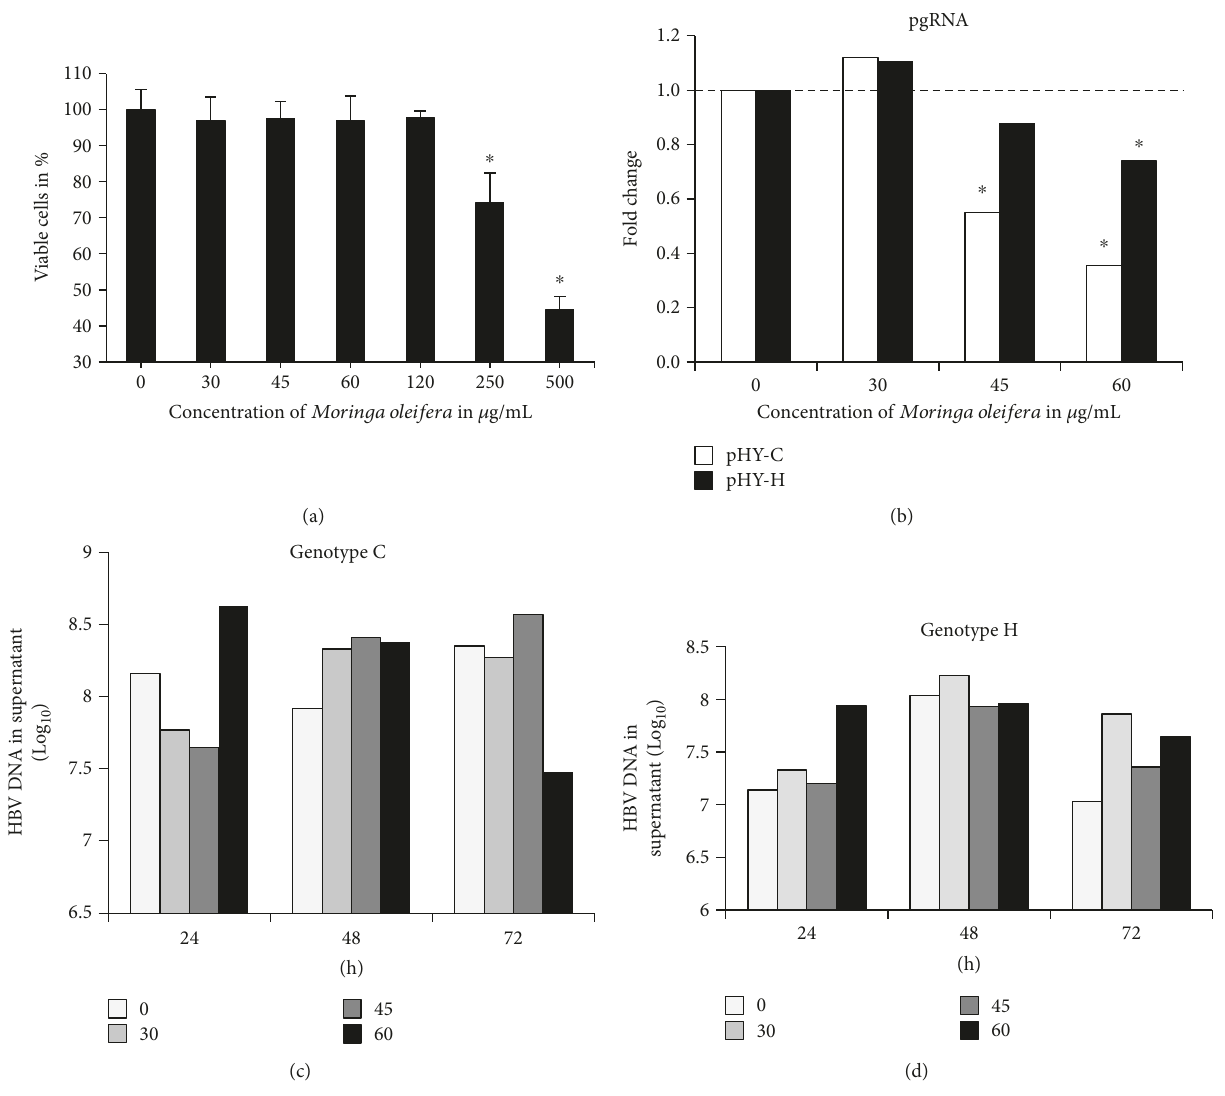
Figure 1: (a) E ff ect of aqueous leaf extract of Moringa oleifera on the viability of Huh7 cells. ∗ p < 0 05 . (b) pgRNA expression of Huh7 cells transfected with genotype C (white bars) or H (black bars) of HBV and treated with Moringa oleifera . Fold change (2 − ΔΔ Ct ) was calculated with reference data without treatment. ∗ p < 0 05 based on Δ Ct values. (c and d) HBV-DNA was quanti fi ed from supernatants recovered at 24, 48, and 72 hours after treatment by real-time PCR (copy number expressed in Log oleifera dose at μ